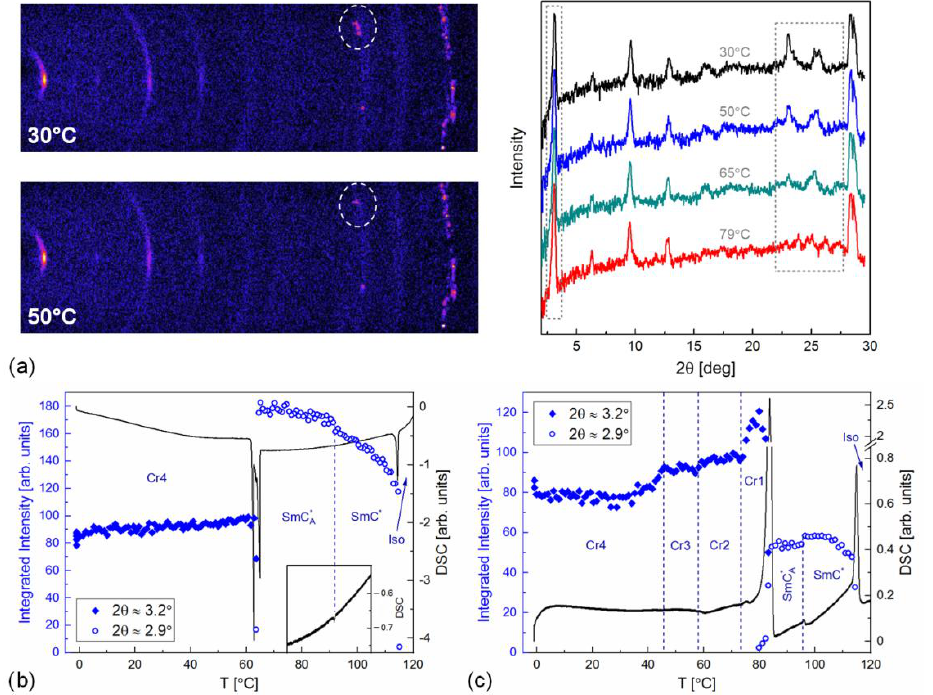
Figure 11. Results of the simultaneous XRD-DSC measurement for 4FF: representative XRD patterns obtained during heating ( a ) and the integrated intensity of the peaks at 2 θ ≈ 3.2 ◦ and 2 θ ≈ 2.9 ◦ compared with the DSC curve on cooling ( b ) and heating ( c ). The double peak at 2 θ ≈ 28 ◦ originates from the aluminium crucible.